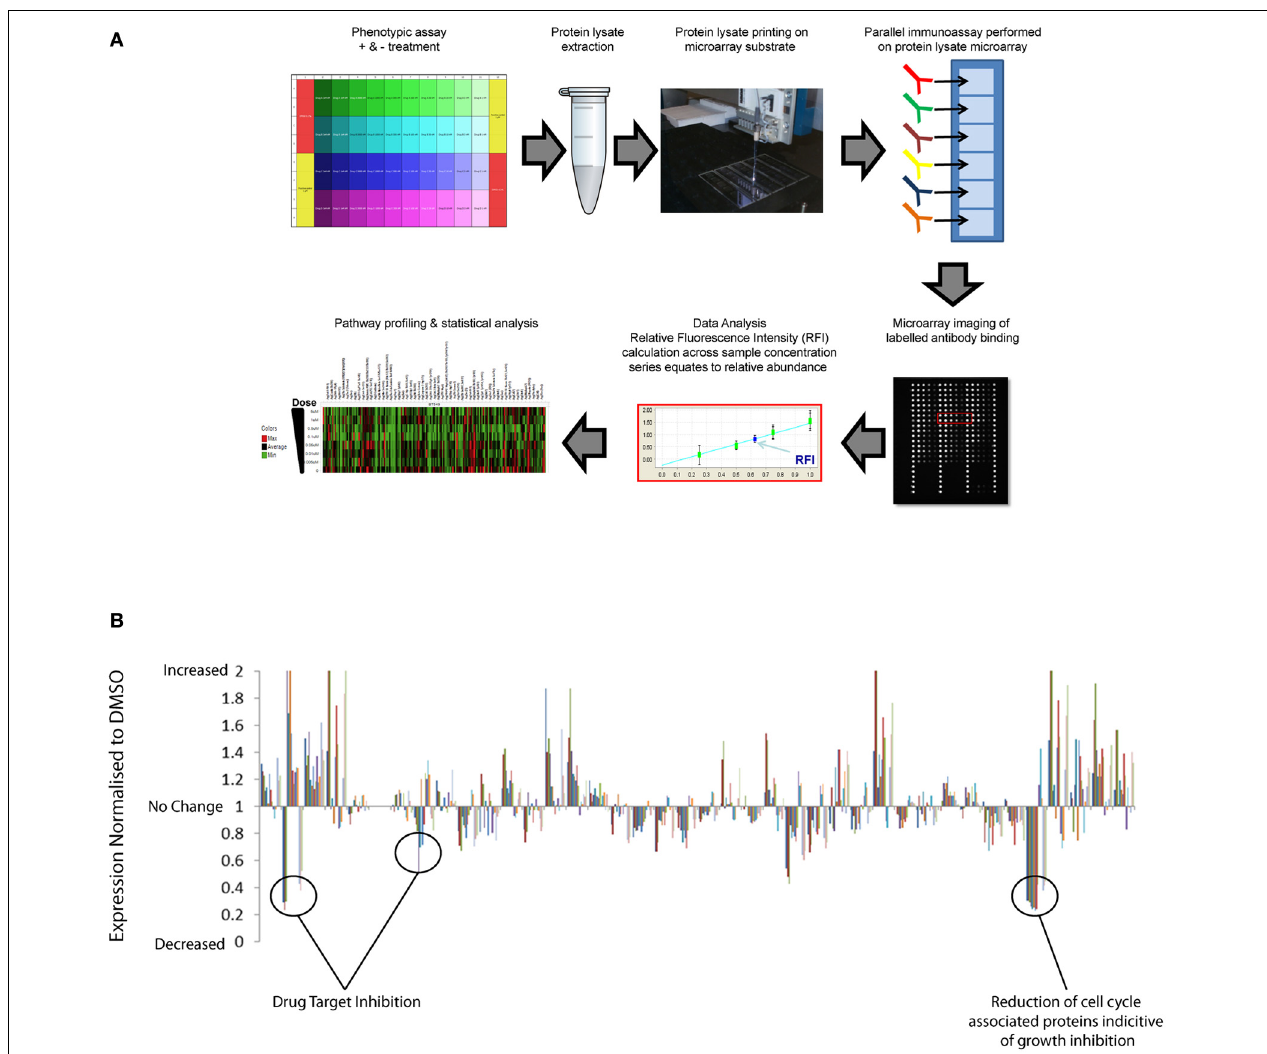
FIGURE 1 | High-throughput reverse phase protein array application to identify drug compound mechanism-of-action and compensatory response. (A) Schematic representation of RPPA workflow: Protein lysates are extracted from multiple samples and deposited across multiple sub-arrays on a microarray by high-precision printing. Validated antibodies are individually addressed to each array, followed by incubation with labeled secondary antibody detection reagent. Antibody binding to each sample is measured by an image-based microarray